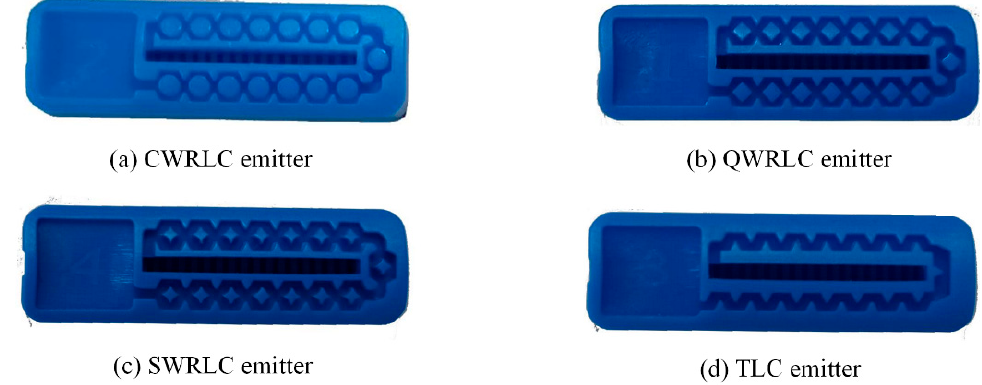
Figure 11. The outlet flow rate and inlet pressure fitted curves of the four emitters.